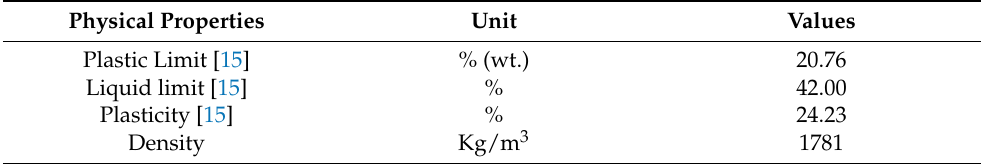
Table 1. Physical properties of TZ clay.